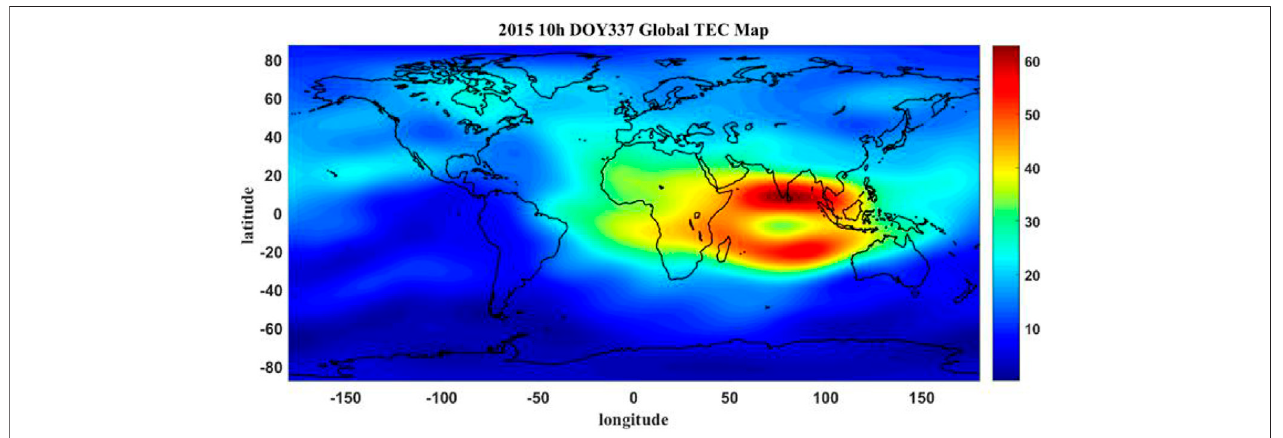
FIGURE 2 | Global ionospheric VTEC